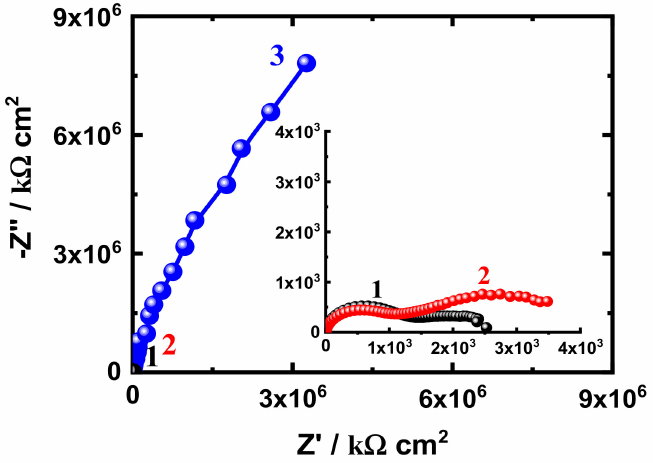
Figure 4. Nyquist plots obtained for (1) SN1, (2) SN3, and (3) SN5 after their immersion for 1 h in 3.5% NaCl solutions.